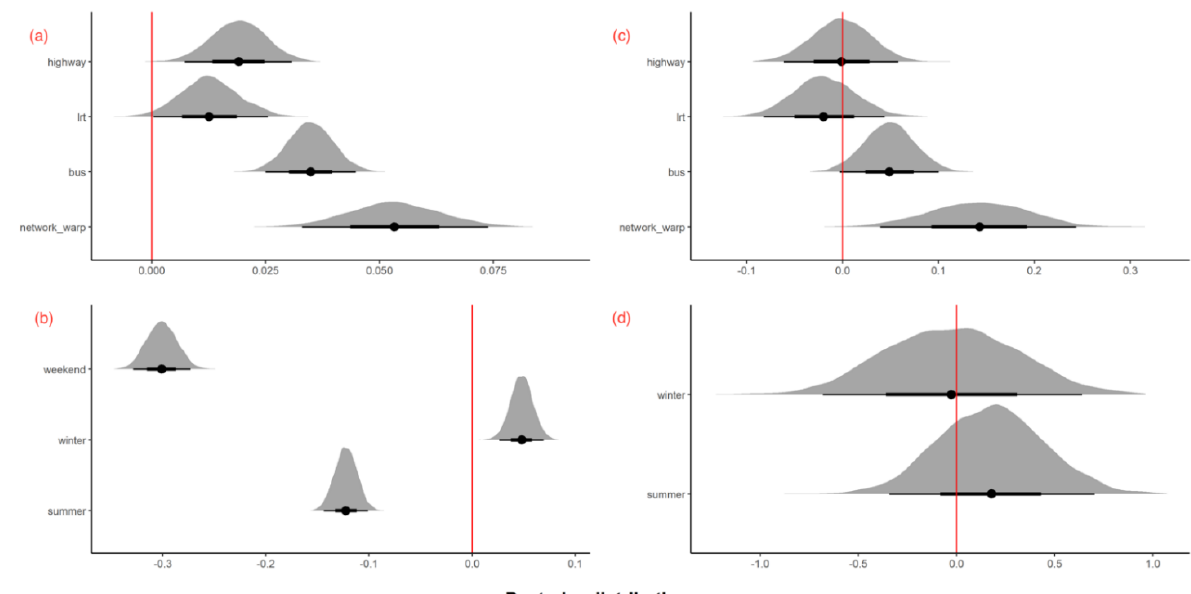
Figure 2. Estimated posterior probability distributions for parameters representing spatial variables for: ( a ) visit length and ( b ) visit frequency, and temporal variables for ( c ) visit length and ( d ) visit frequency. All distributions presented here were estimated using the full commute models.